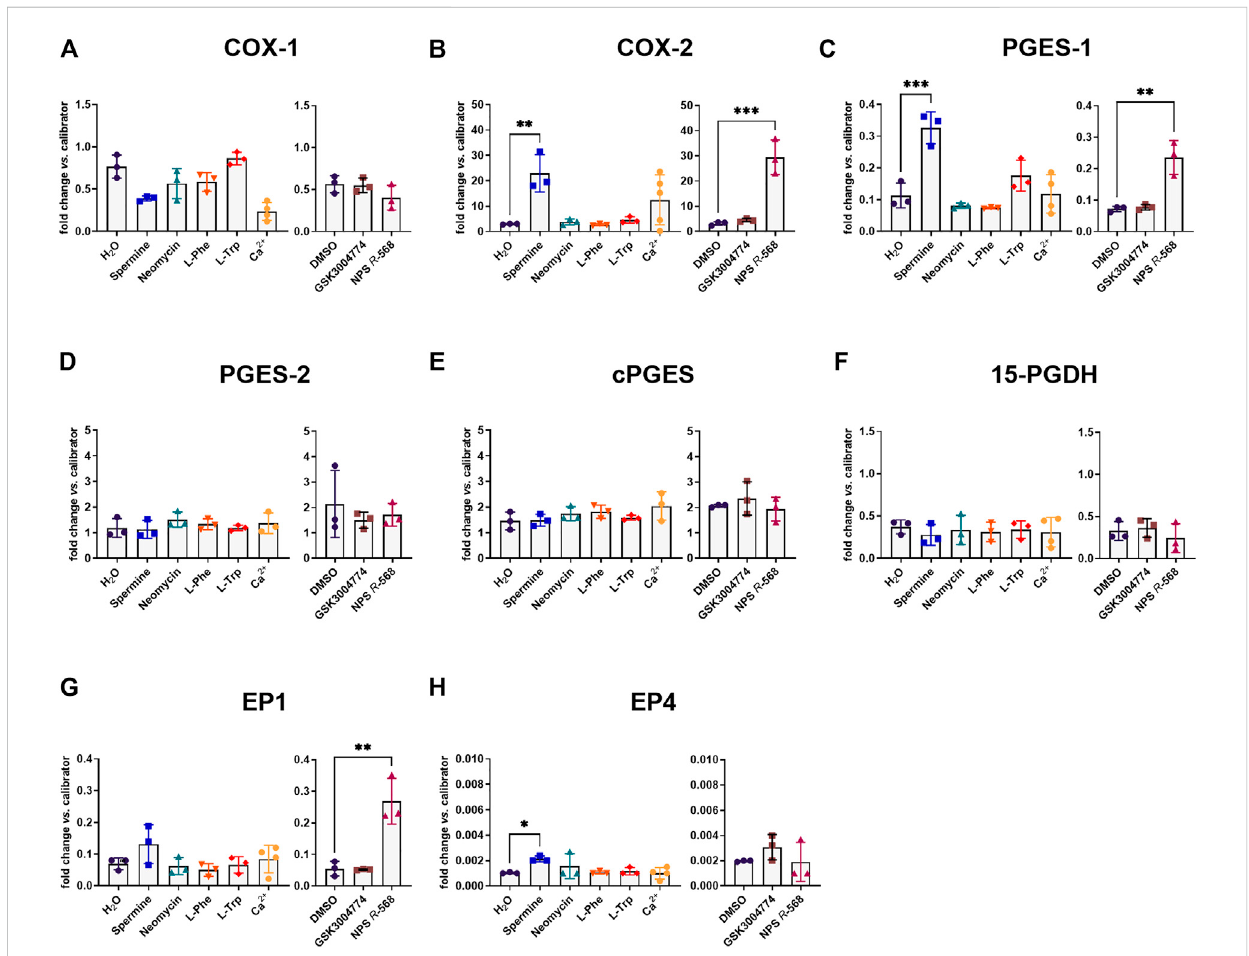
FIGURE 2 Induction of PGE 2 pathway genes by CaSR ligands in HT29 CaSR − GFP cells. Relative gene expression of (A) COX-1, (B) COX-2, (C) PGES-1, (D) PGES-2, (E) cPGES, (F) 15-PGDH, (G) EP1, and (H) EP4 in HT29 CaSR − GFP cells after 4 h treatment with CaSR ligands (left panel: H 2 O as vehicle control, 5 mM spermine, 300 µM neomycin, 1 mM L-Phe, 1 mM L-Trp, and 5 mM Ca 2+ ) or CaSR modulators (right panel: 0.1% DMSO as vehicle control, 10 µM GSK3004774, and 1 µM NPS R -568). Mean ± SD, N = 3 – 5, one-way ANOVA with Dunnett ’ s post hoc test vs. vehicle control (H 2 O or 0.1% DMSO), ** p < 0.01, *** p <